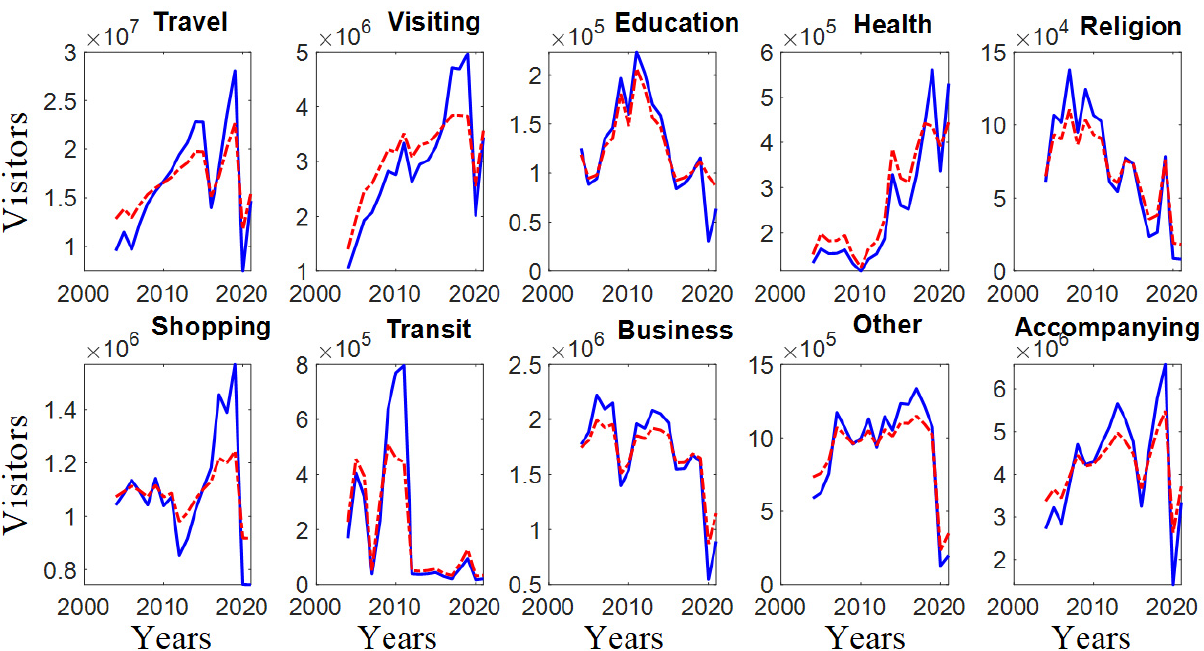
Figure 4. Real and estimated results. The solid blue and dotted red lines represent the real and estimated outputs, respectively.